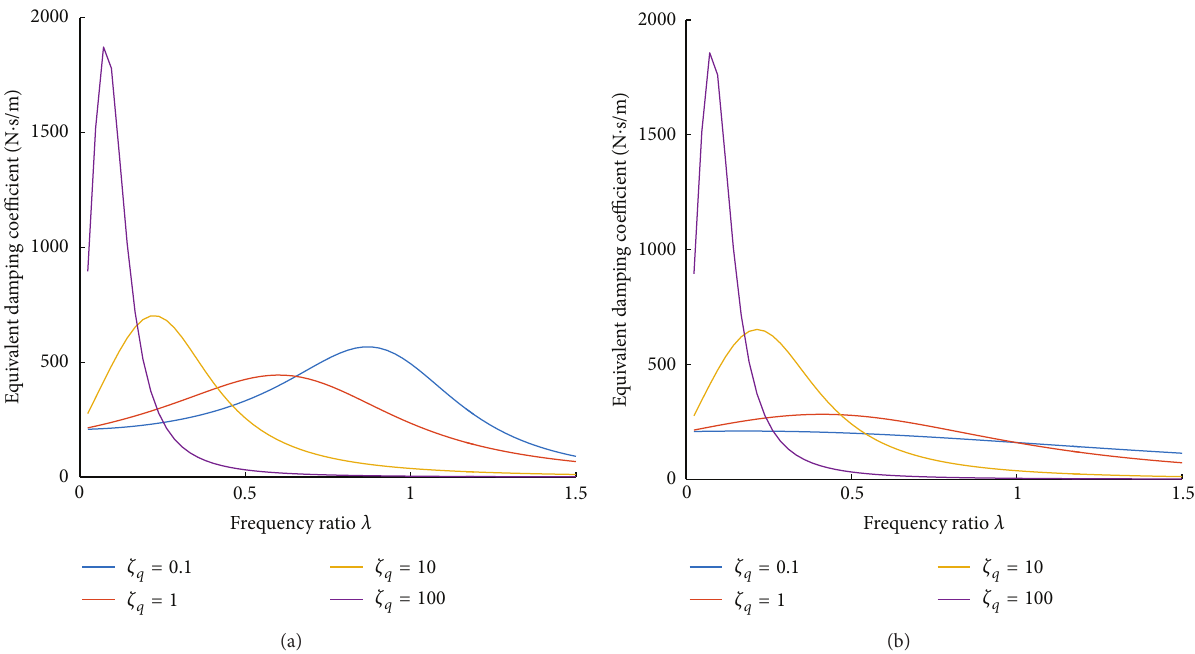
̸= 0 . (b) Numerical simulations of the equivalent eq